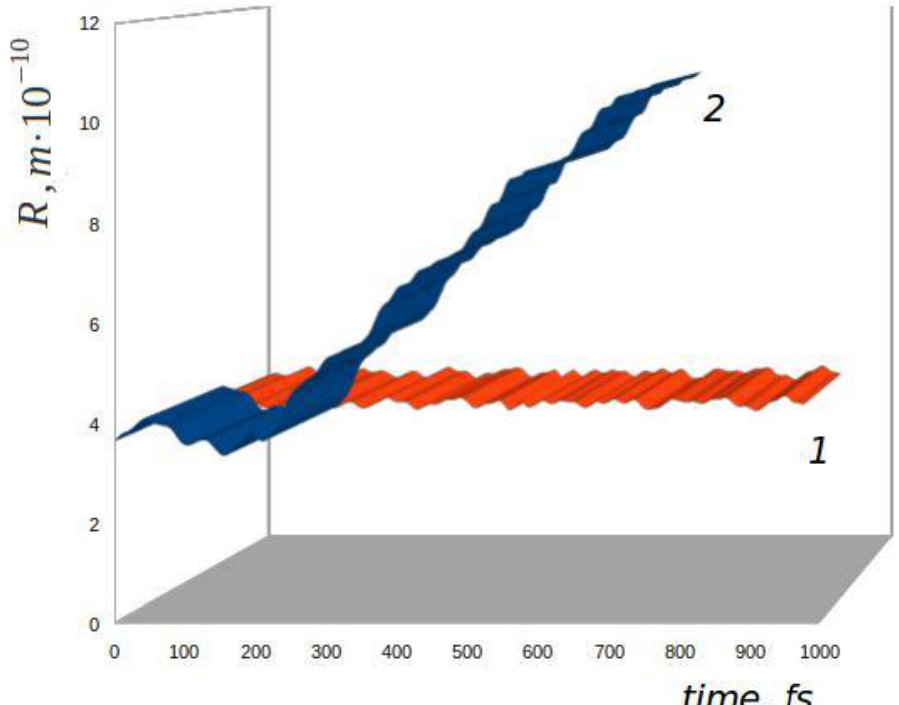
Figure 4. The dependence of the distance between C1 and C5 atoms on the time of molecular dynamic modeling: 1—a molecule in a singlet state, 2—in a triplet state. For a molecule in a singlet state the R distance does not undergo significant changes,